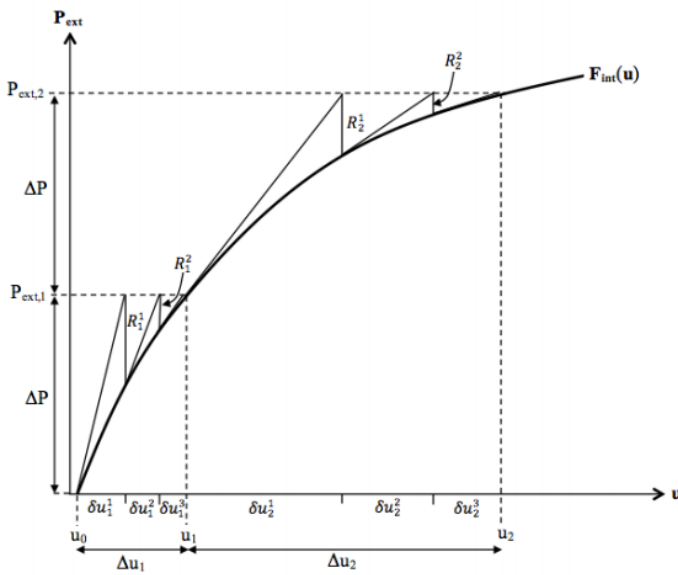
Figure 1. Incremental – iterative solution method [24] .